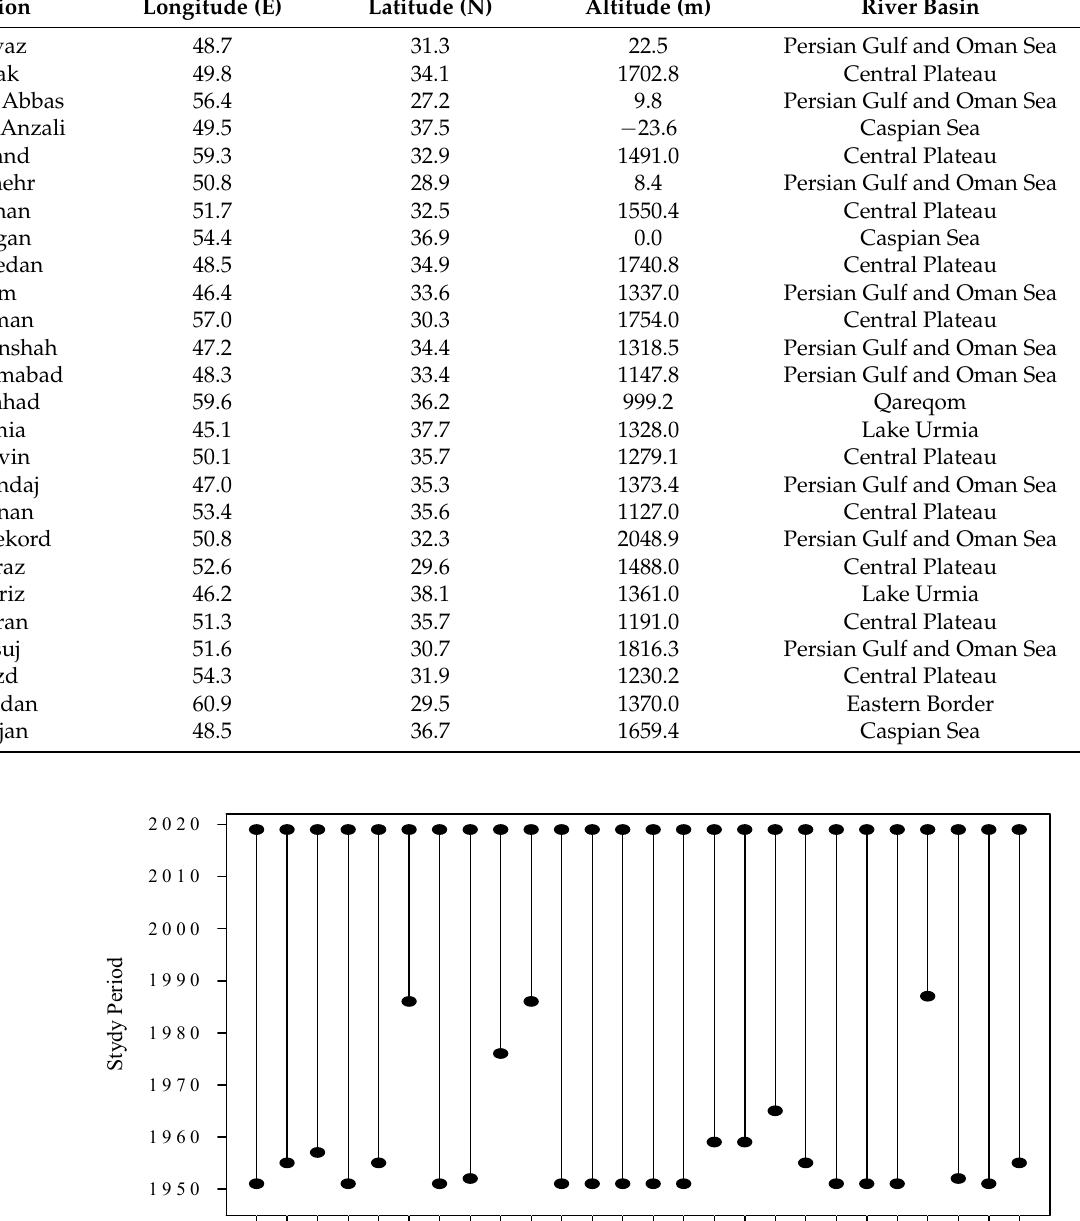
Table 1. Geographical characteristics and location of the selected stations.